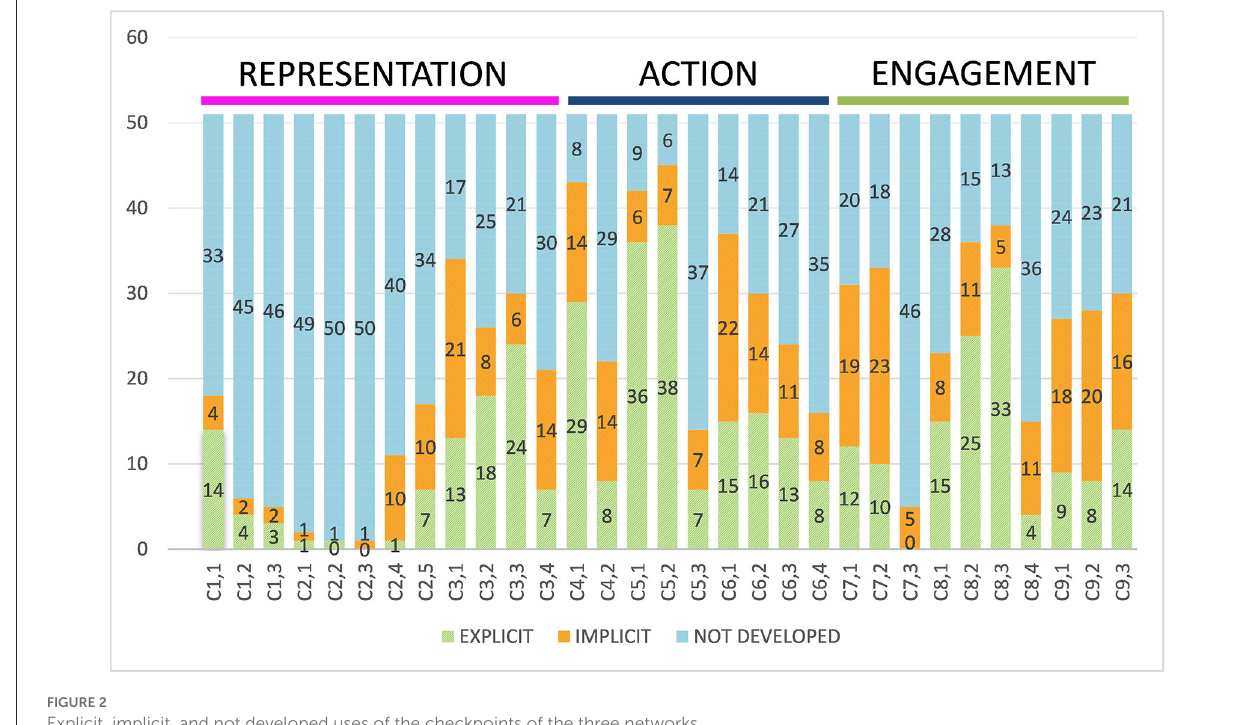
FIGURE2 Explicit, implicit, and not developed uses of the checkpoints of the three networks.